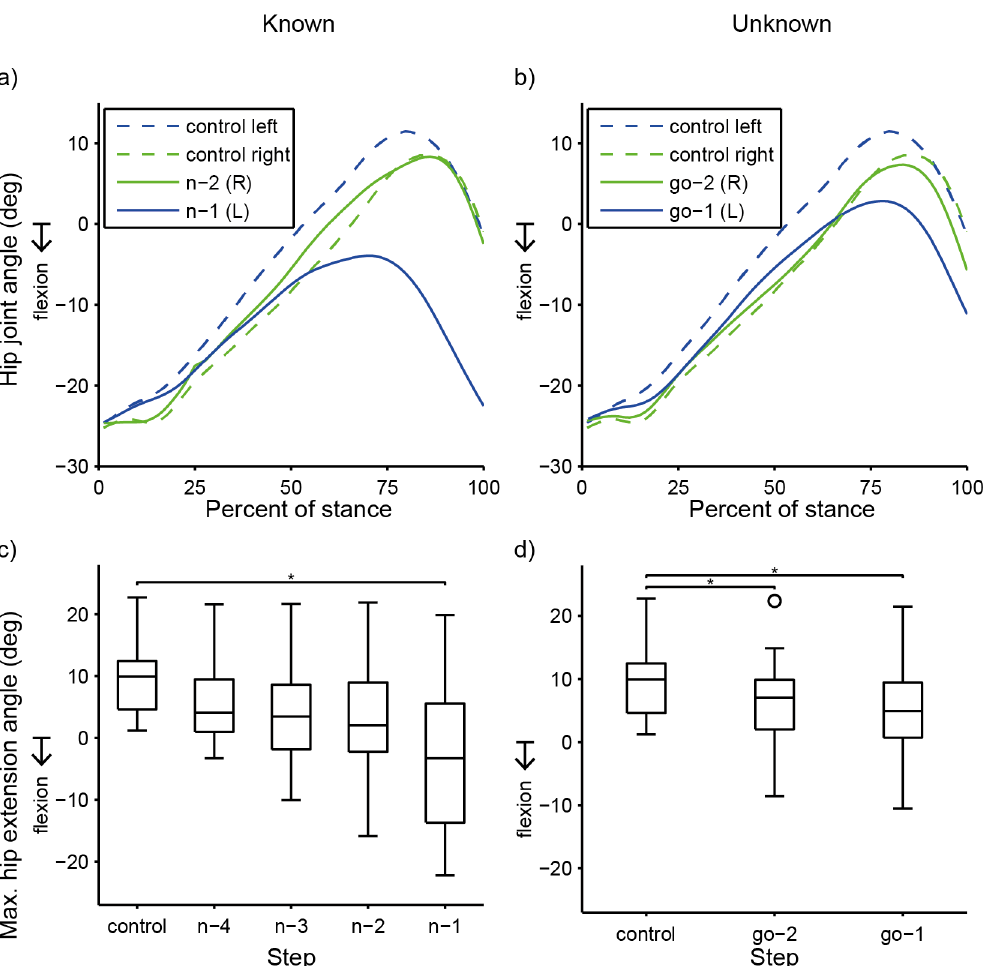
Fig 5. Hip Joint Angle. Example hip joint angle data for one subject comparing a Straight trial vs. a) a Known left trial and b) an Unknown trial. c, d) Each box plot is collapsed across limb side to show main effect of step on peak stance phase hip extension angle. Each box represents 12 subjects ’ data (two subjects excluded). c) Known. The hip was significantly more flexed at the n-1 step compared to the control step. d) Unknown. The hip was significantly more flexed at both steps immediately preceding the “ GO ” signal compared to the control step. ( * )Step is significantly different (p < 0.05) from